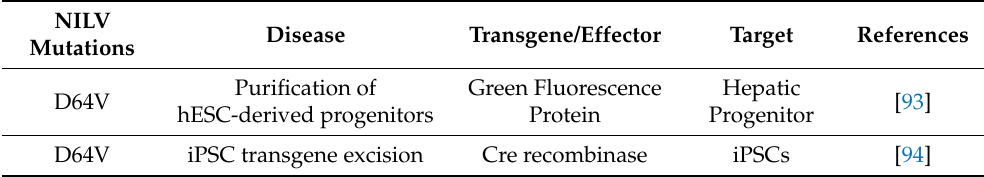
Table 6. Summary of elements used in developing non-integrating lentiviral vectors (NILVs) for cell-type differentiation in pre-clinical studies conducted by the cited research teams. Important components of vector systems are provided in the